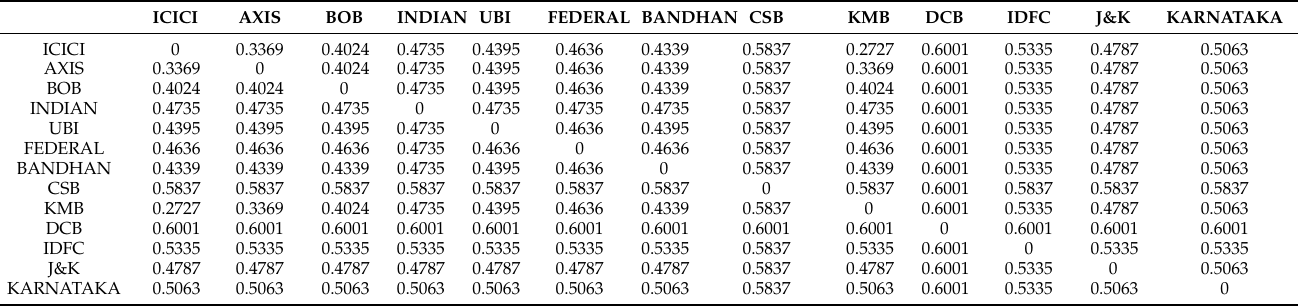
Table 9. Adjacency matrix of the strength of connectedness (last component) (row and column headers are same as Table 8).